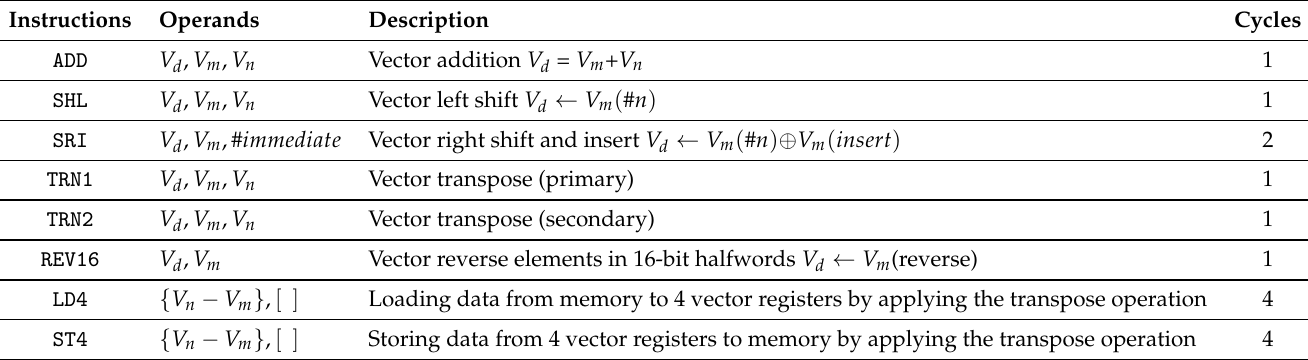
Table 1. Summary of ASIMD instructions used in this paper